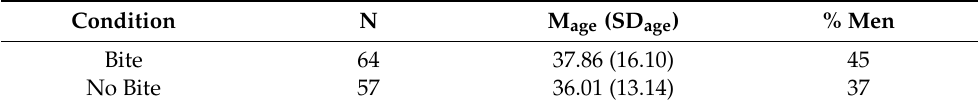
Table A1. Demographics of the different conditions in Study 1.